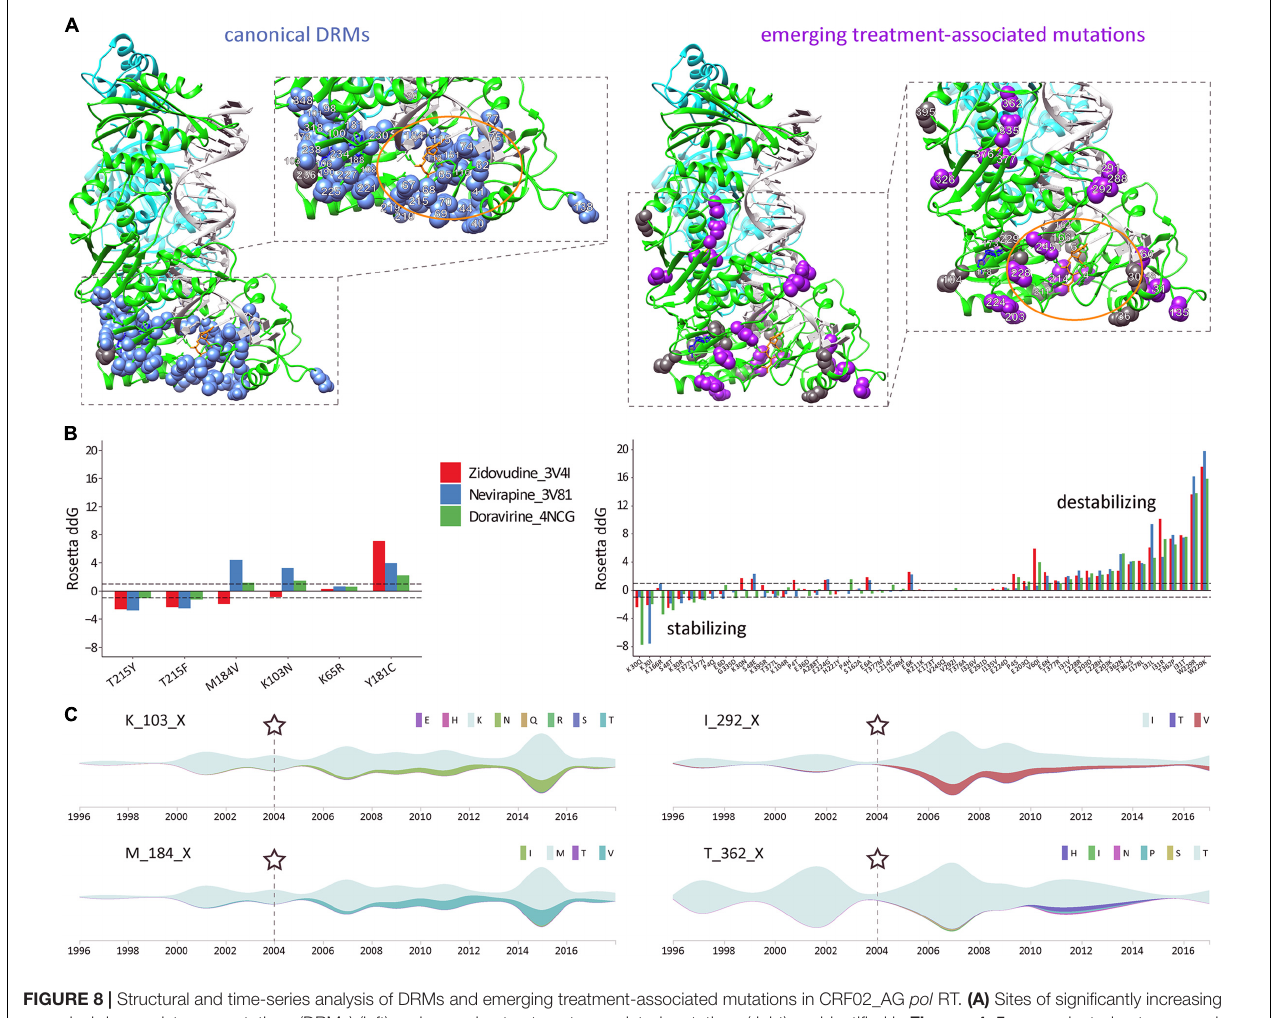
FIGURE 8 | Structural and time-series analysis of DRMs and emerging treatment-associated mutations in CRF02_AG pol RT. (A) Sites of significantly increasing canonical drug resistance mutations (DRMs) (left) and emerging treatment-associated mutations (right), as identified in Figures 4 , 5 , are projected onto a complex RT structure. Detailed views of the drug-binding regions with annotated aa sites are shown in boxes to the right, and an orange oval highlights the active center. The RT models were generated using crystal structures of RT with DNA and the NRTI AZT-TP (PDB 3V4I) and RT with DNA and the NNRTI nevirapine (PDB 3V81). The nevirapine (blue) and AZT-TP (orange) molecules were placed together for illustration purposes (using structural overlay in Chimera). DRM residues are displayed as blue or gray spheres, according to a significant increase or decrease from pre- to post-cART periods, respectively ( P < 0.05, according to Figure 4 ). Accordingly, treatment-associated mutation residues are displayed as magenta or gray spheres, according to a significant increase or decrease from pre- to post-cART, respectively ( P < 0.05, according to Figure 5 ). (B) The effect of selected canonical DRMs (most prevalent in Cameroon and/or highest mutational scoring) and all significantly emerging CRF02_AG treatment-associated mutations on three different published RT protein structures were analyzed with the Cartesian ddg application (Rosetta). ddG values > 1 and < 1 are characteristic for destabilizing and stabilizing mutations, respectively. Mutations are listed from left to right according to increasing destabilizing effects. (C) Time-series analysis of significantly increasing mutations in HIV-1 CRF02_AG pol RT during cART scale-up in Cameroon. Streamgraphs in silhouette mode display mutations among the studied sequence on the y-axis along the timeline on the x-axis. The gray-green color indicates the absence of mutations (and the presence of the dominant aa residue). According to the legend to the right, other colors indicate the presence of mutations/minority variants. The RT aa site and its dominant/consensus aa are indicated to the left of each streamgraph. Shown is a selection of two canonical drug resistance mutation sites (left) and two emerging treatment-associated mutation sites (right) with a significant increase in mutations over time. Asterisks and dashed lines mark the time point of cART implementation in